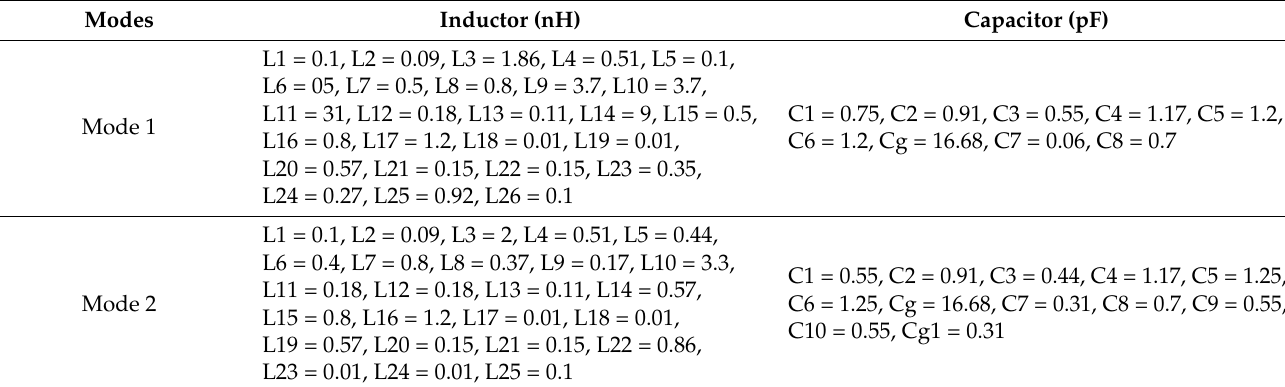
Figure 12. Influence of L 10 on S-parameters in ( a ) mode 1 and ( b ) mode 2.